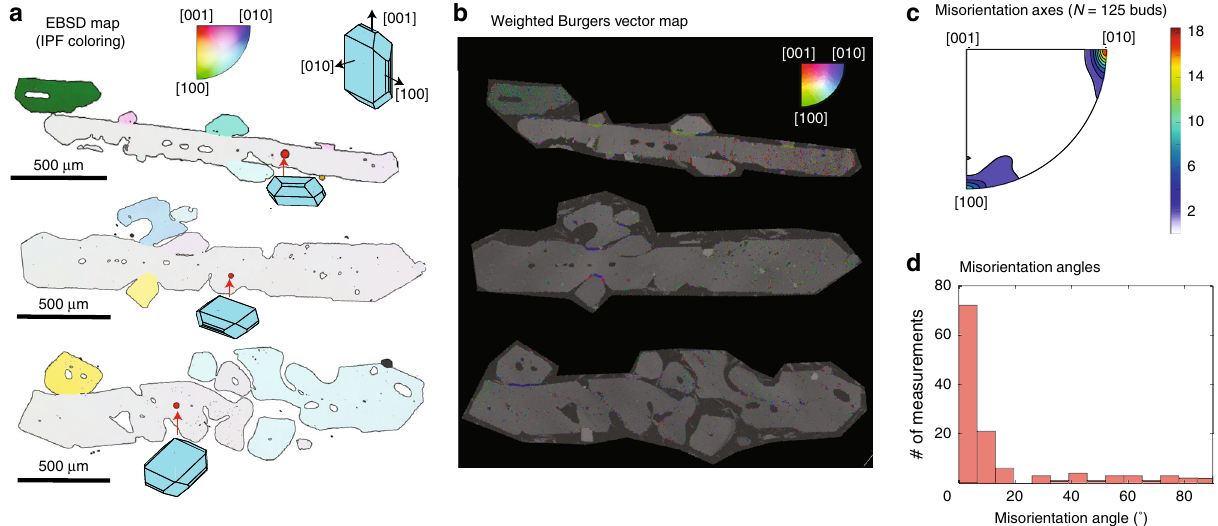
Fig. 3 Crystallographic signatures of dendritic branching in olivines from West Greenland picrites. a Electron backscatter diffraction (EBSD) maps colored using the inverse pole fi gure (IPF) key as in Fig. 2, with the mean orientation of the grain containing the red dot set to white. To emphasize the larger range of misorientation in dendrite branches compared with the distorted olivines in Fig. 2, the IPF color key is adjusted so that pixels with misorientation angles >20° are colored black. 3D olivine crystals are overlain to allow visualization of the orientation of the dendritic olivines with respect to the three crystallographic directions of olivine. b Weighted Burgers vector directions (WBVDs) overlain on band contrast maps ([100] = green, [010] = blue, [001] = red]). Scale for both images shown on EBSD map. c Misorientation axes for 125 dendritic buds from West Greenland picrites (misorientation angle >1°). The color scale has units of “ multiples of uniform distribution ” . d Histogram of misorientation angles between adjacent dendrite buds. Seventy percent of dendritic buds are misoriented from the host crystal by >5° (see ref. 34